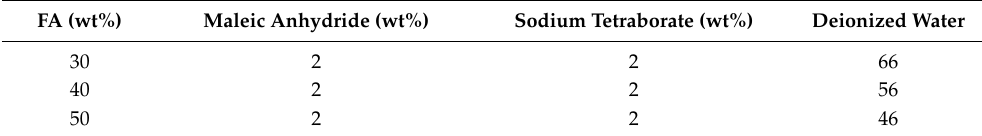
Table 1. Formulation of furfuryl alcohol (FA) impregnation solution.